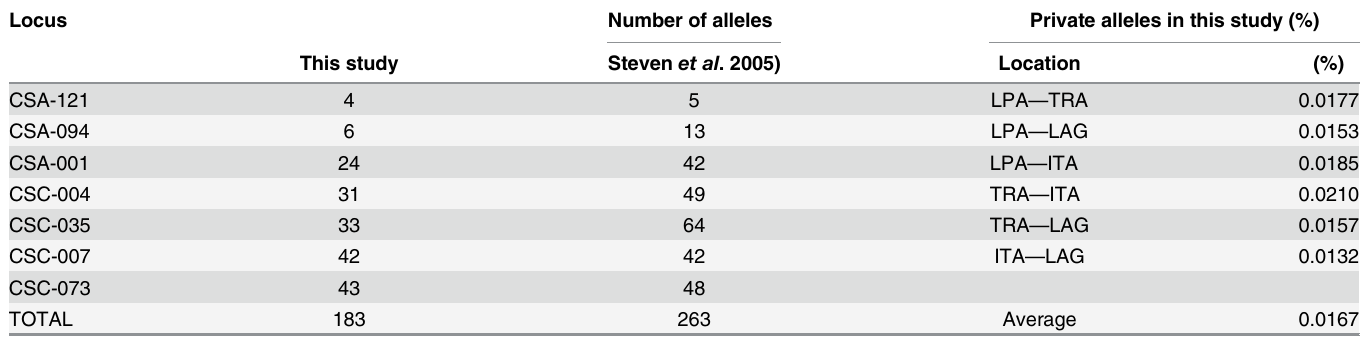
Table 3. Number of alleles to same seven loci found in this study and in Steven et al ., (2005), as well as private alleles in this study, separated by pairwise populations.